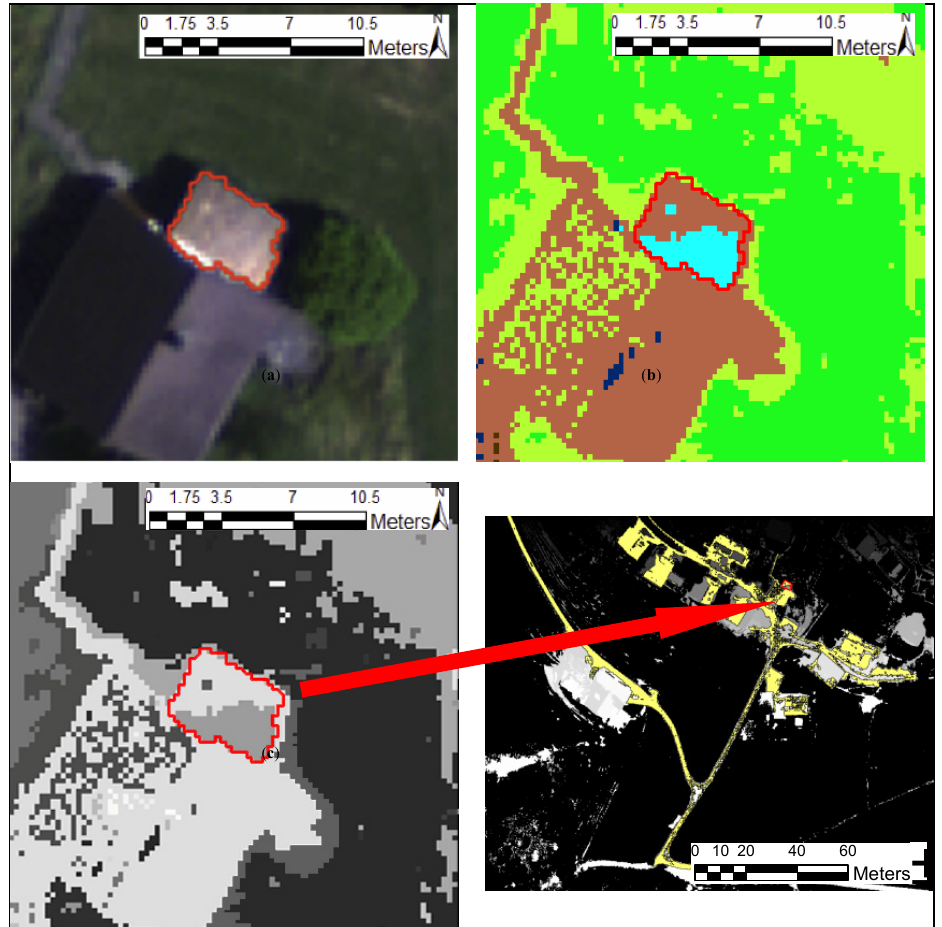
Figure 6. Target (mapped) image-object selection in the SIAM™ map of the Leica image at coarse semantic granularity, refer to Equation (12). ( a ): The closed red contour identifies a reference image-object of the LC class “ buildings ”, selected by an expert photointerpreter in the Leica image. ( b ): SIAM™’s pre-classification map of the Leica image at coarse semantic granularity. The boundary of the reference segment is superimposed in red. ( c ): SIAM™’s segmentation map automatically generated from the SIAM™ pre-classification map at coarse semantic granularity. Each (connected) segment is identified by a different integer value and (should be) depicted in a different gray-tone. The boundary of the reference segment is superimposed in red. ( d ): The yellow segment is the target (mapped) object selected according to the reference-test segment pair selection criterion, see Equation (12). Spatial adjacency and spectral similarity of roads and buildings leads to the selection of a mapped object (in yellow) whose extension covers a large portion of the image, equivalent to an undersegmentation error. Hence, the USQI and FEOQI-T values tend to be low when the semantic granularity of the SIAM™ pre-classification map is